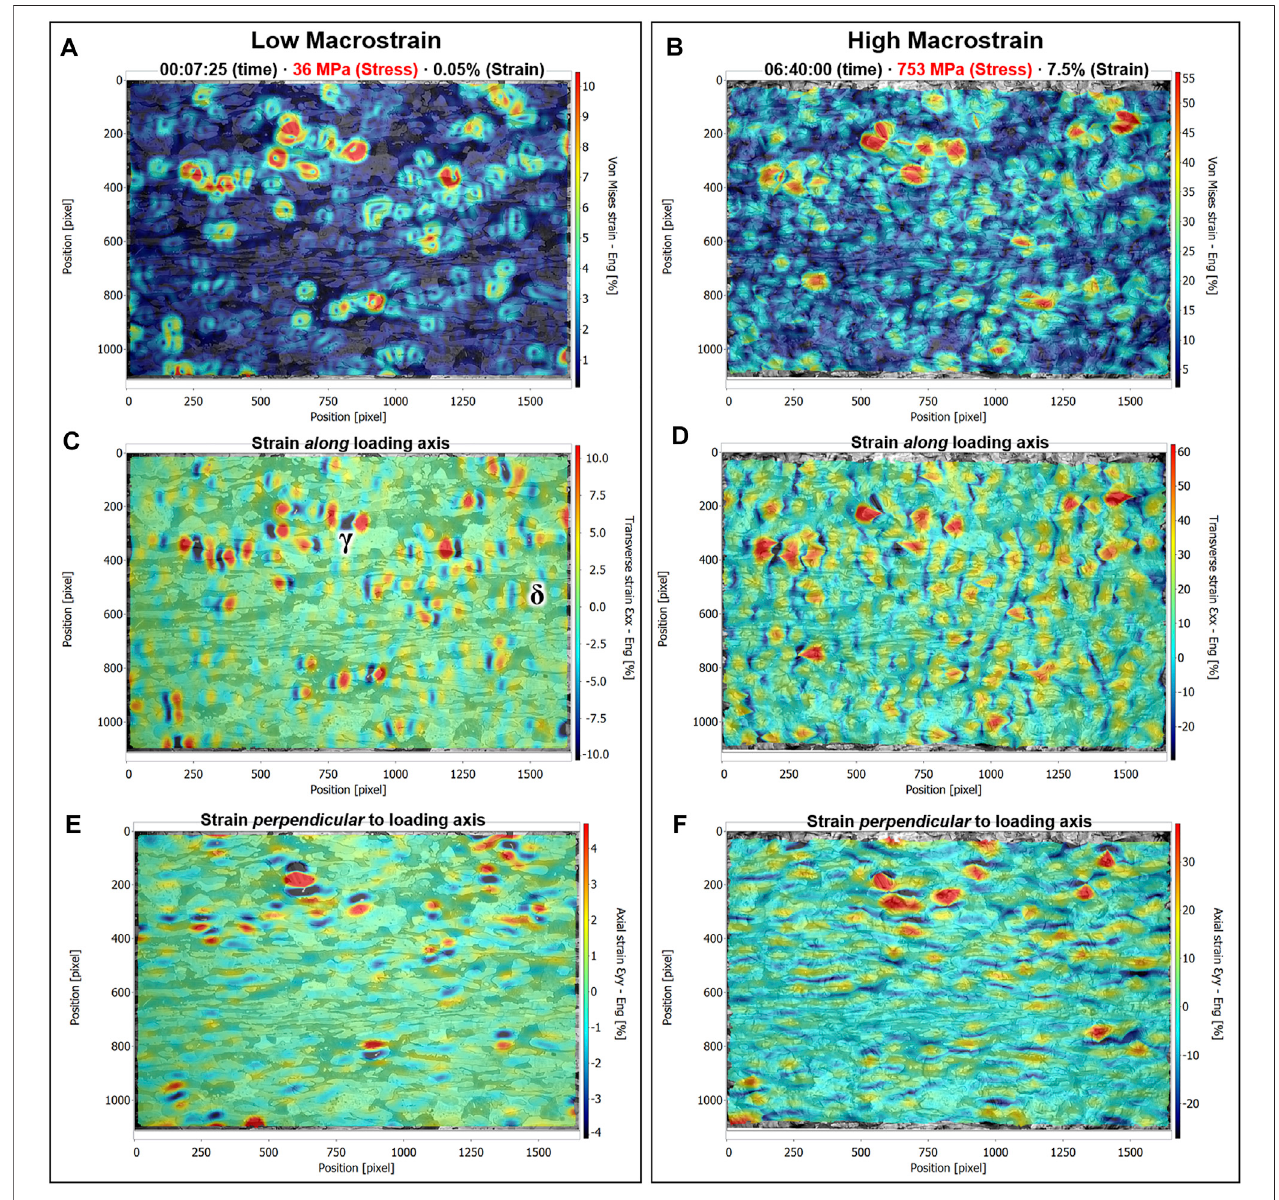
FIGURE 13 | DIC analysis results showing (A,B) the von Mises microstrain evolution, (C,D) the strain evolution along the loading axis, (E,F) the strain evolution perpendicular to the loading axis during mechanical elongation of the microstructure without hydrogen charging. The maps in (A,C,E) show strain evolution for applied low stress (36 MPa), and those in (B,D,F) show the progressed deformation after plastic deformation (753 MPa). Note the microstructure behind the strain maps showing austenite and ferrite grains in contrast. The loading axis is directed to the horizontal of the images. The time format above each fi gure shows the elapsed timeduringthemechanicalelongationexperimentinhours:minutes:secondsforall fi guresbelow.ThestressgiveninMPaindicatestheappliedstresswiththetester.The strain value on top of the fi gures shows the macroscopic strain measured by the tester ’ s extensometer.